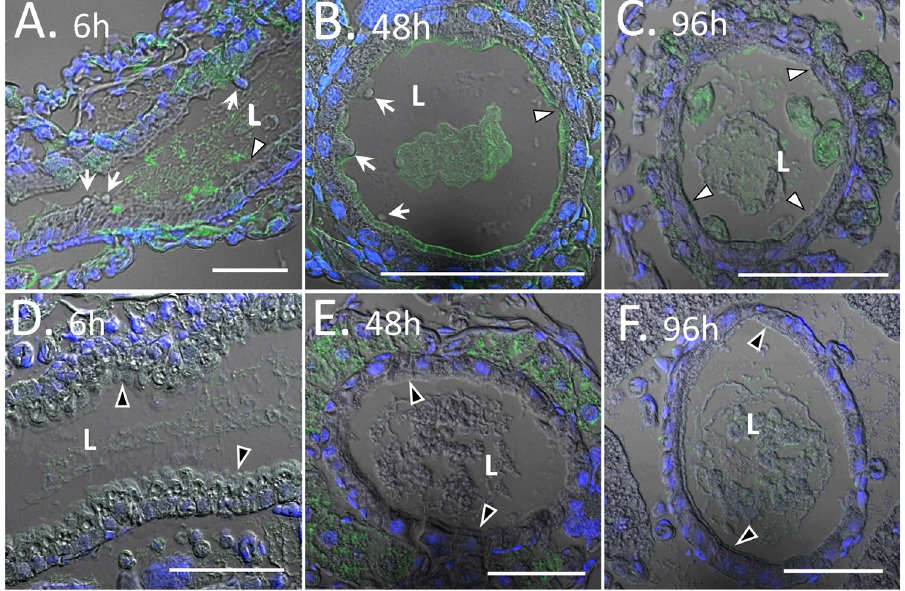
Fig 9. Western corn rootworm midgut morphology after feeding with Vpb4Da2. Vpb4Da2 staining by Alexa-fluor- 488 conjugated secondary antibody is in green. Nuclei staining by DAPI is in blue. (A) Longitudinal section of the midgut after 6 h exposure to Vpb4Da2. (B) Cross section after 48 h exposure to Vpb4Da2. (C) Cross section after 96 h exposure to Vpb4Da2. (A) and (B) White arrows indicate blebbing of the epithelial cells. (A), (B) and (C) White arrowheads designate a complete or near complete loss of the apical microvilli layer. (D) , (E) , and (F) Are untreated controls where black arrowheads indicate the intact apical microvilli layer. Scale bars are all 50 μ m.